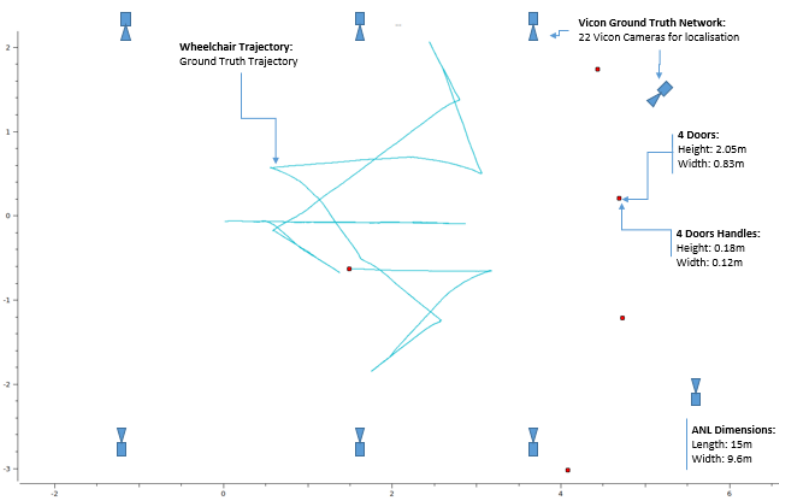
Figure 8. ANL environment including: Wheelchair, doors, doors handles, and Vicon cameras ground truth